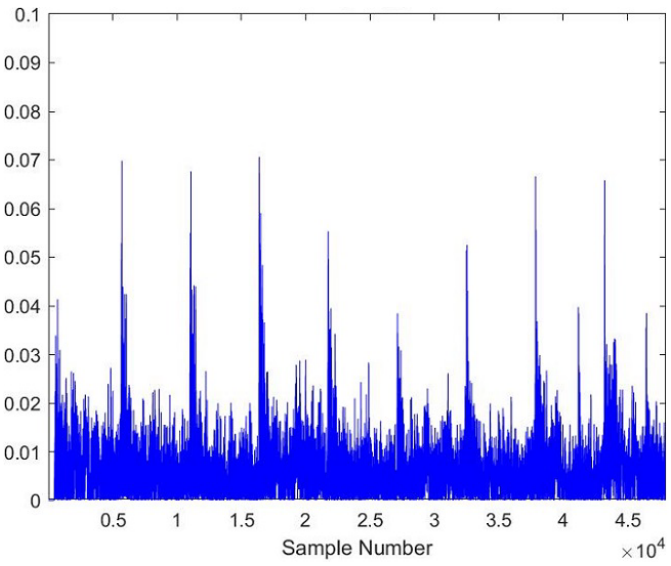
Figure 5. RMS plot of Hardwood, Average Tool, 3 mm depth-of-cut.